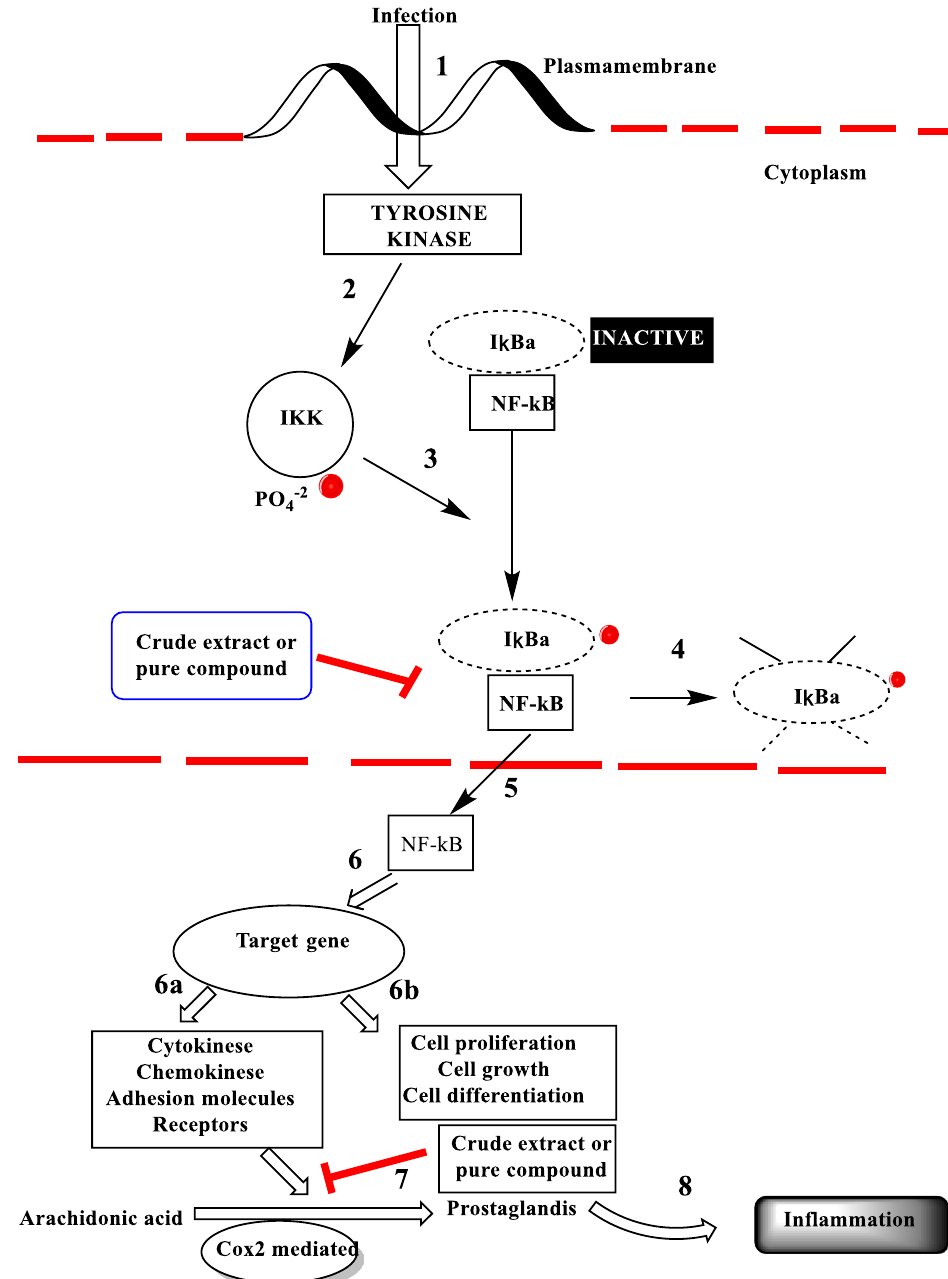
Fig. 3 Antiinflammatory mechanism of action of crude extract or pure compounds from C.